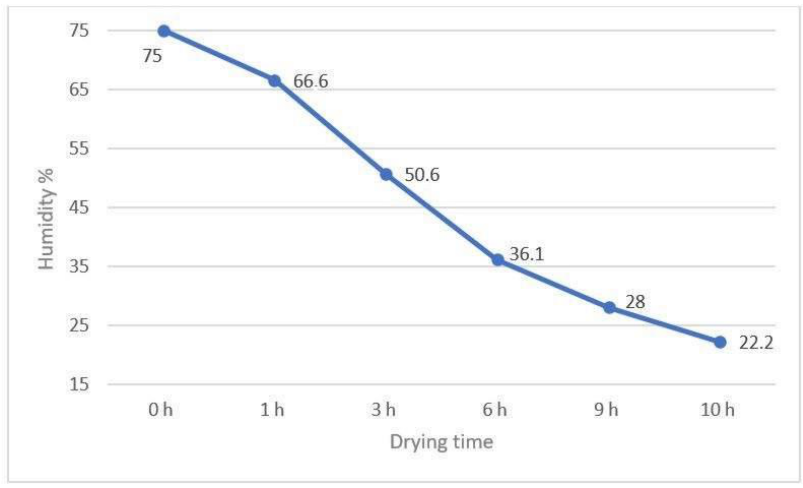
Figure 14. Drying curve—product moisture in chamber 4.